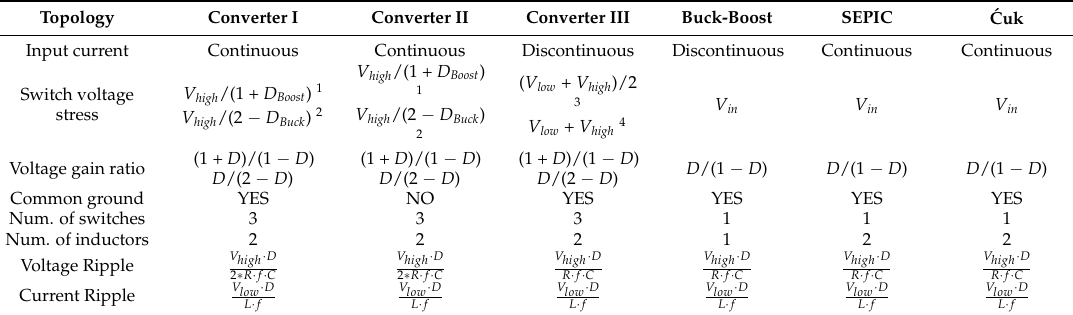
Table 1. Comparison of proposed converters and conventional converters.